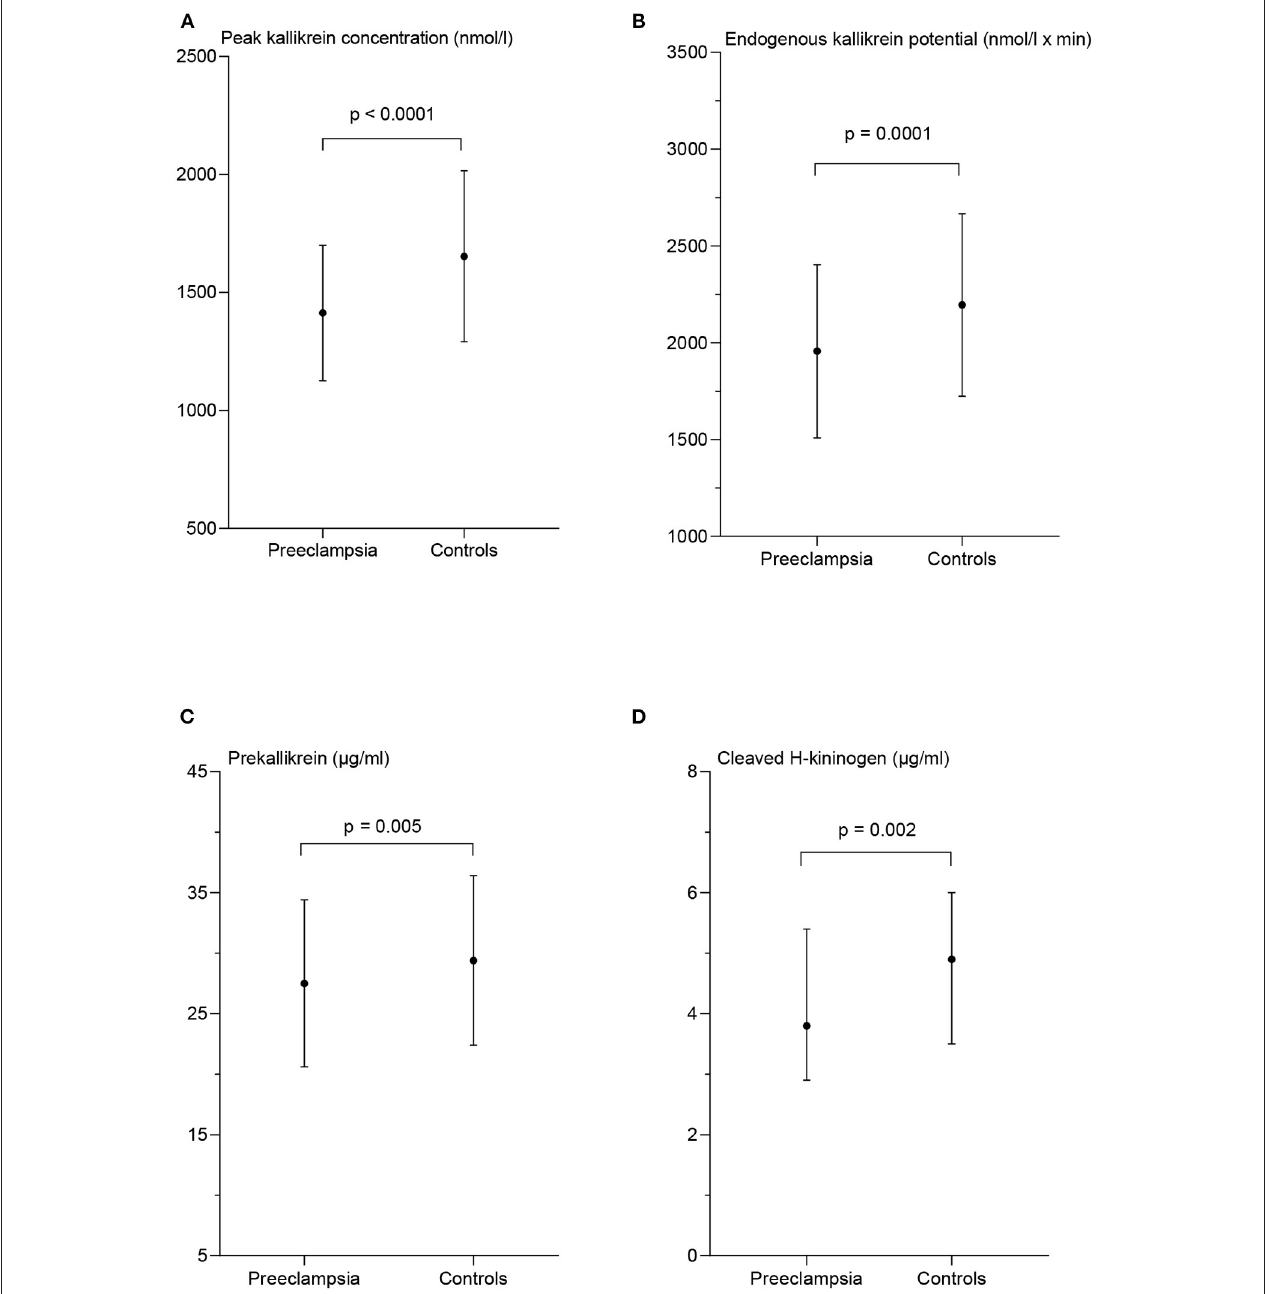
FIGURE 2 | Measures of contact activation in patients with preeclampsia and matched controls. Peak kallikrein concentration (A) , endogenous kallikrein potential (B) , and prekallikrein concentration (C) are presented as mean ± standard deviation. The concentration of cleaved H-kininogen (D) is presented as median and interquartile range. p -values from the paired t -test (A–C) and the Wilcoxon matched-pairs signed rank test (D) between the two patient